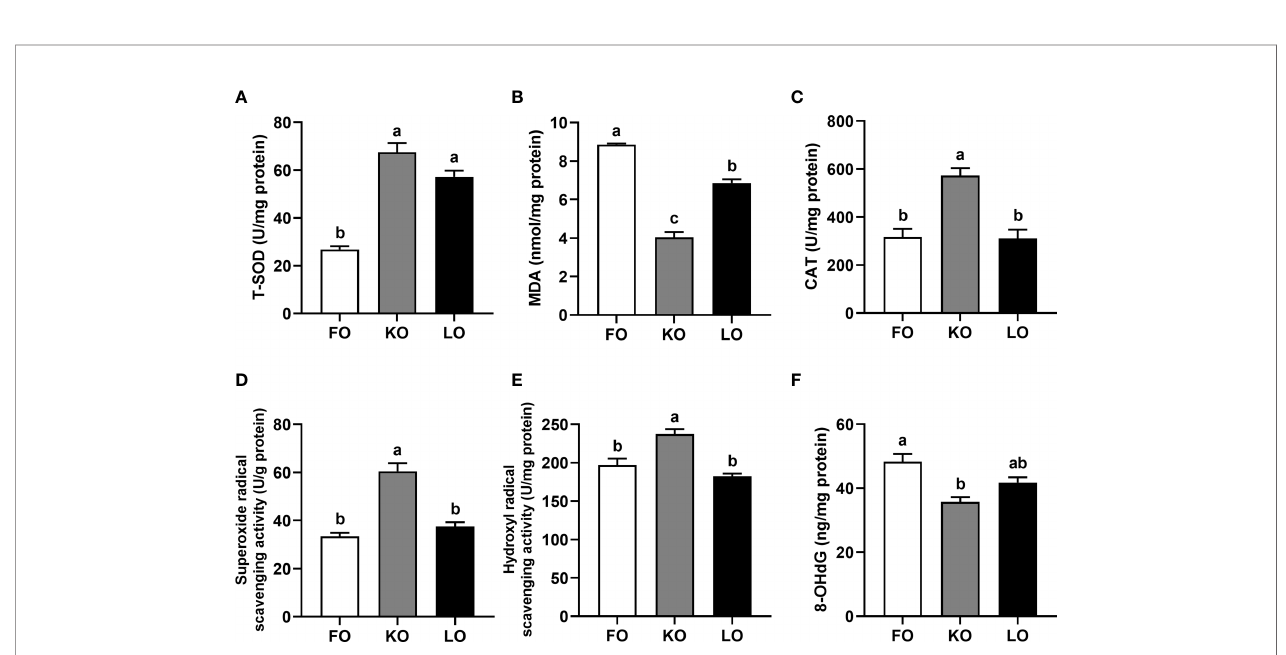
FIGURE 2 | Effectsofdifferent dietarylipidsourcesonindicators ofoxidativestressinthehepatopancreasofswimmingcrab. Valuesare mean± SE (n= 4). Barswithdifferent superscripts representsigni fi cantdifferencebyone-factor ANOVA followedbyaTukey ’ s multiple rangepost-hoctest(P< 0.05). (A) T-SOD, totalsuperoxidedismutase; (B) MDA, malondialdehyde; (C) CAT,catalase; (D) Superoxideradicalscavengingactivity; (E) Hydroxylradicalscavengingactivity; (F) 8-OhdG, 8-hydroxydeoxyguanosine.